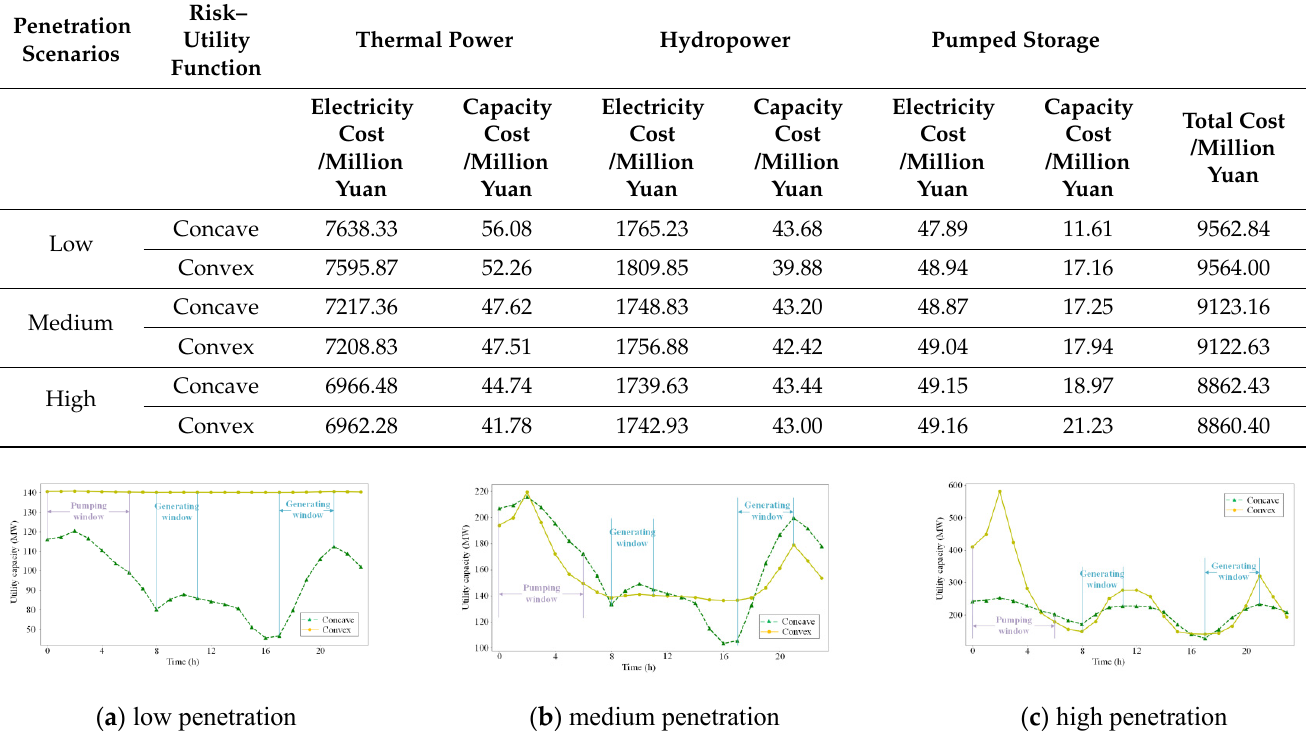
Table 2. Comparison of units quotation cost under different penetration scenarios.